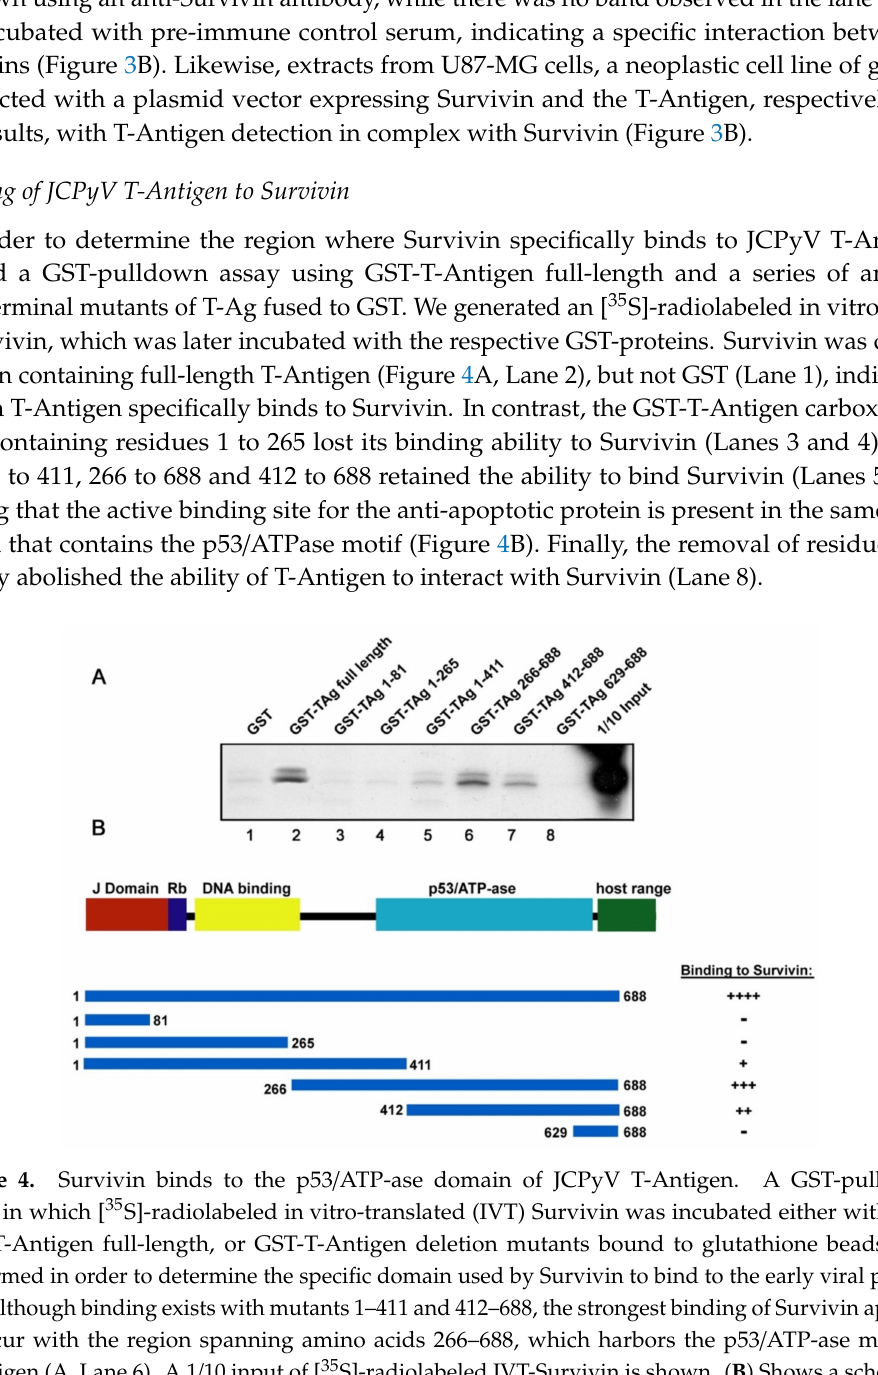
T-Antigen (A, Lane 6). A 1 / 10 input of [ 35 S]-radiolabeled IVT-Survivin is shown. ( B ) Shows a